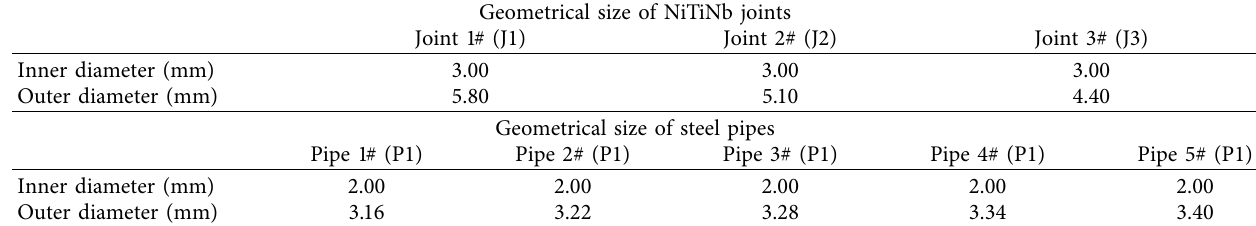
Table 2: Geometrical size of NiTiNb joints and steel pipes.